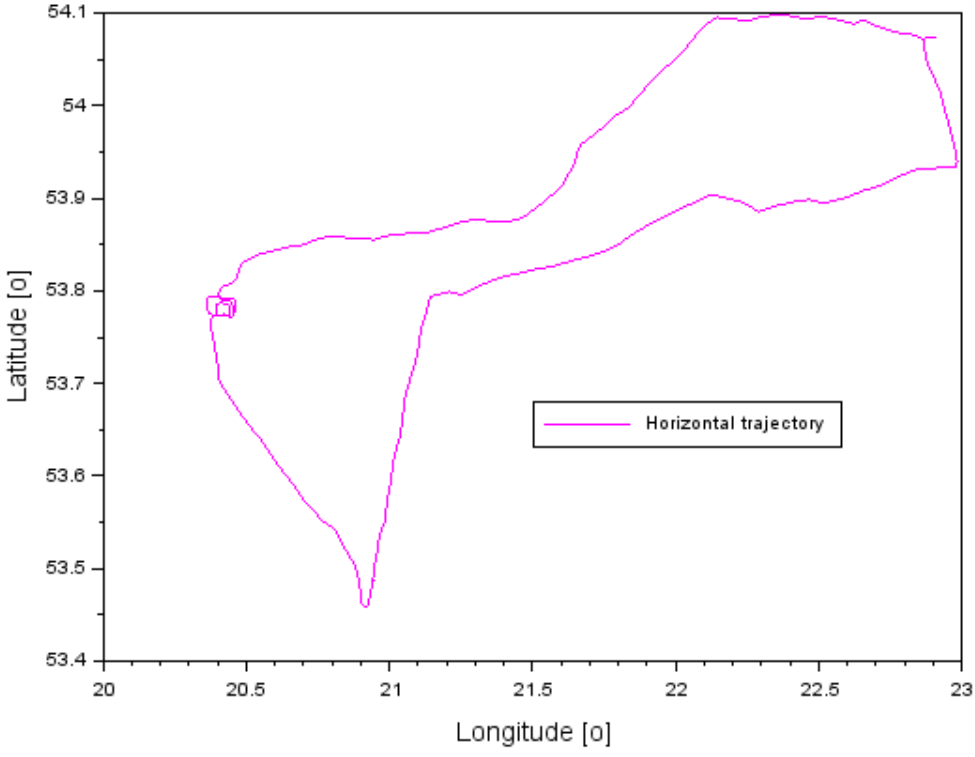
Figure 3. The horizontal trajectory of Diamond DA 20-C1 aircraft.